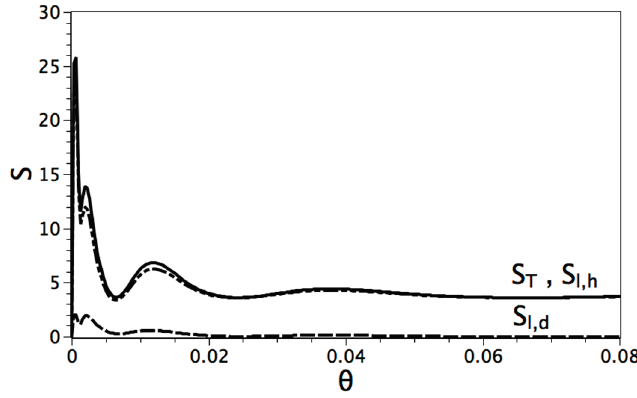
Figure 13. Variation of Nu with Ra (problem in Figure 1a) for Pr 50 = .